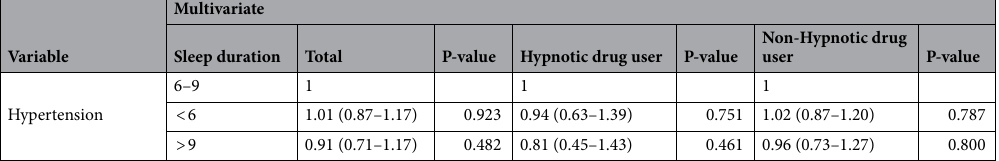
Table 3. Odds ratios (with 95% CIs) of long and short sleep duration in hypnotic drug users and non-users in relation to demographic factors, habits, and medical history. *Cannot be calculated because the number of people in this category is zero. WSI : wealth score index, BMI body mass index, MI myocardial ischemia, CHD chronic heart